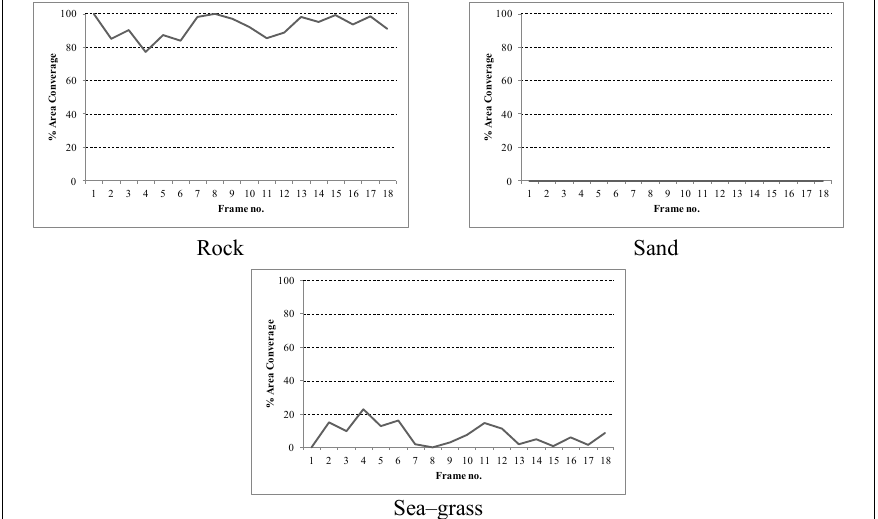
Fig. 7. Habitat map of Region one